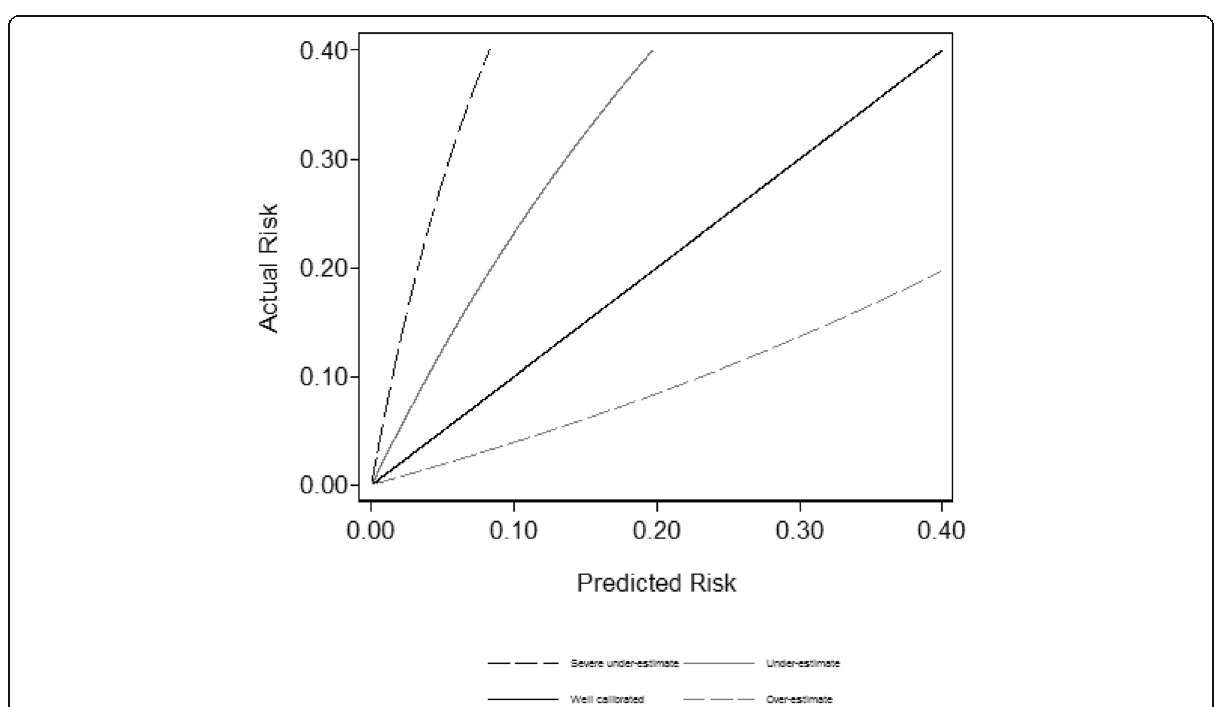
Fig. 1 Calibration plot for various continuous prediction models of differing degrees of miscalibration. All prediction models have an AUC of 0.75 for predicting an event with prevalence 20%. The prediction models include the following: a well-calibrated prediction model, a model that is miscalibrated such that it overestimates risk, a prediction model that underestimates risk, and a prediction model that more severely underestimates